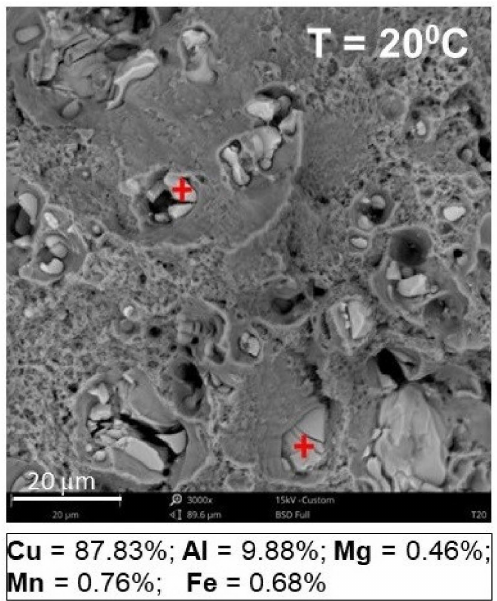
Figure 17. EDS analysis